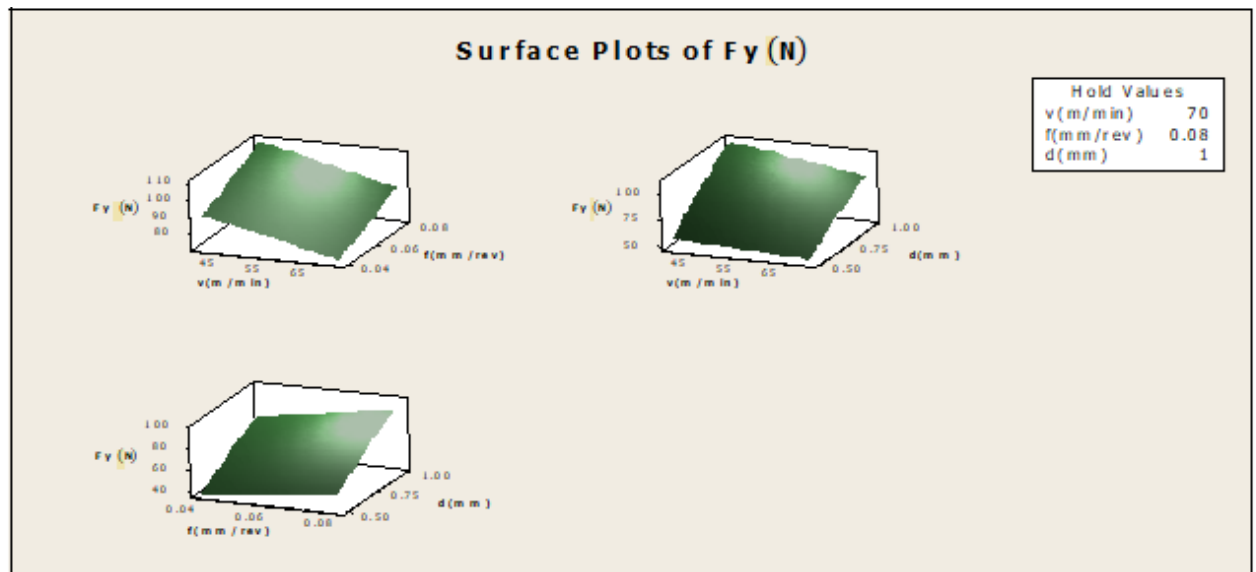
Figure 8. Surface plot for Fx .